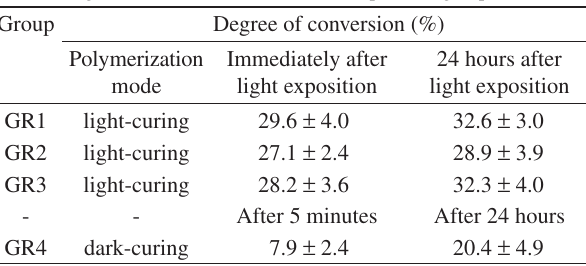
Table 2. Degree of conversion of the different specimen groups.